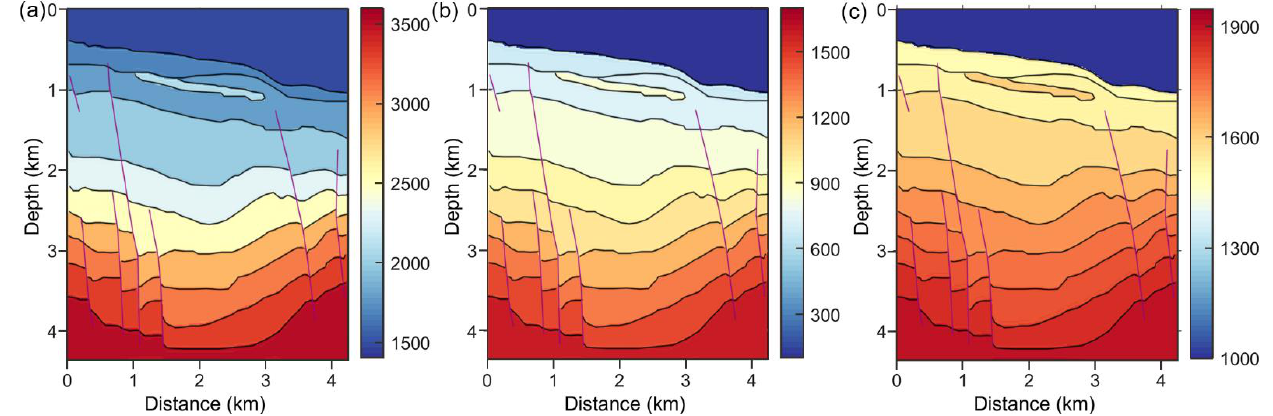
Figure 4. The true models for the synthetic data: ( a ) P-wave velocity, ( b ) S-wave velocity, and ( c ) density. The black lines indicate the stratigraphic horizons and the red lines indicate the faults.